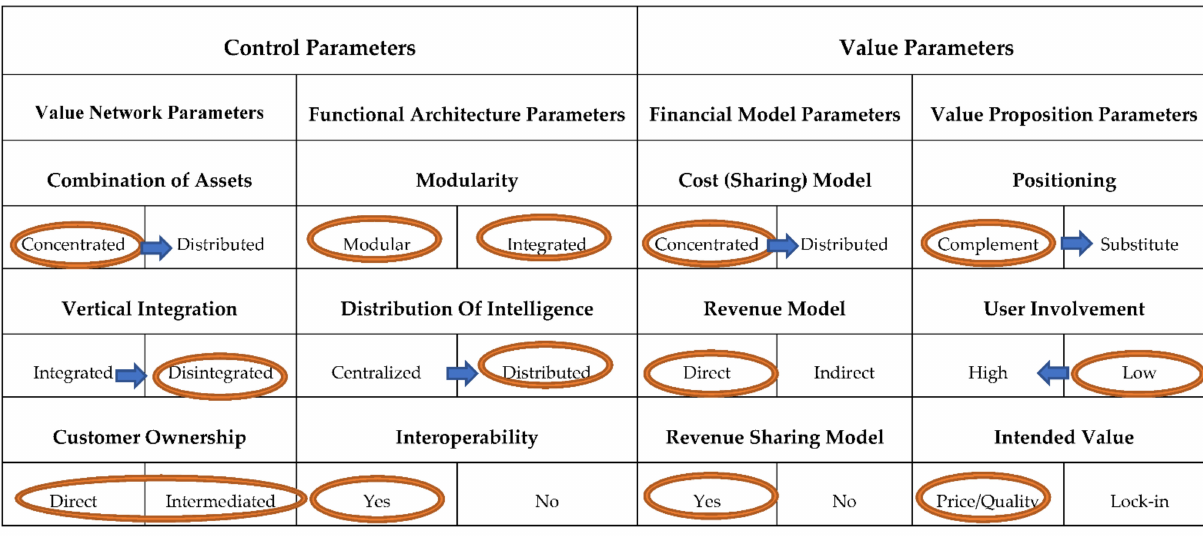
Figure 5. Results of analyzing the electricity market by using the business model.